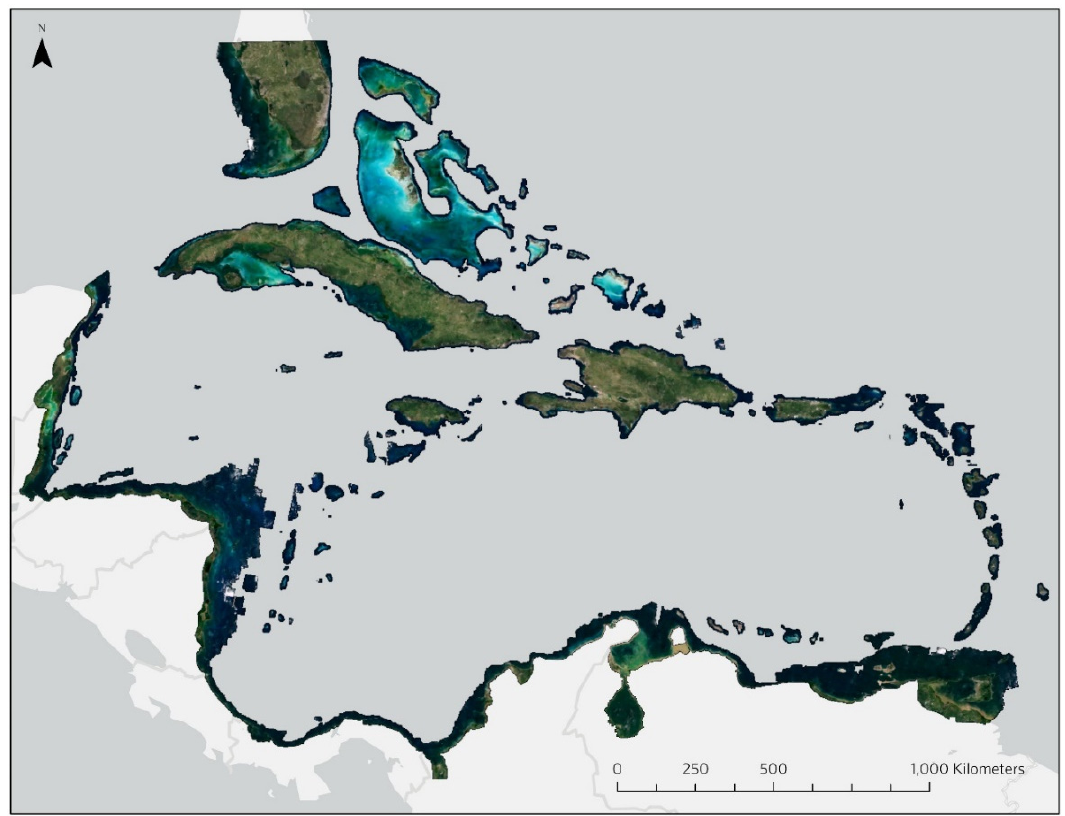
Figure 4. Final shallow area (<30 m depth) seamless, non-cloudy, four-band image composite of 38,642 PS Dove scenes for the Caribbean Basin that were acquired between 1 October 2017 and 15 September 2019 and normalized using a MODIS color target with seamlines removed.